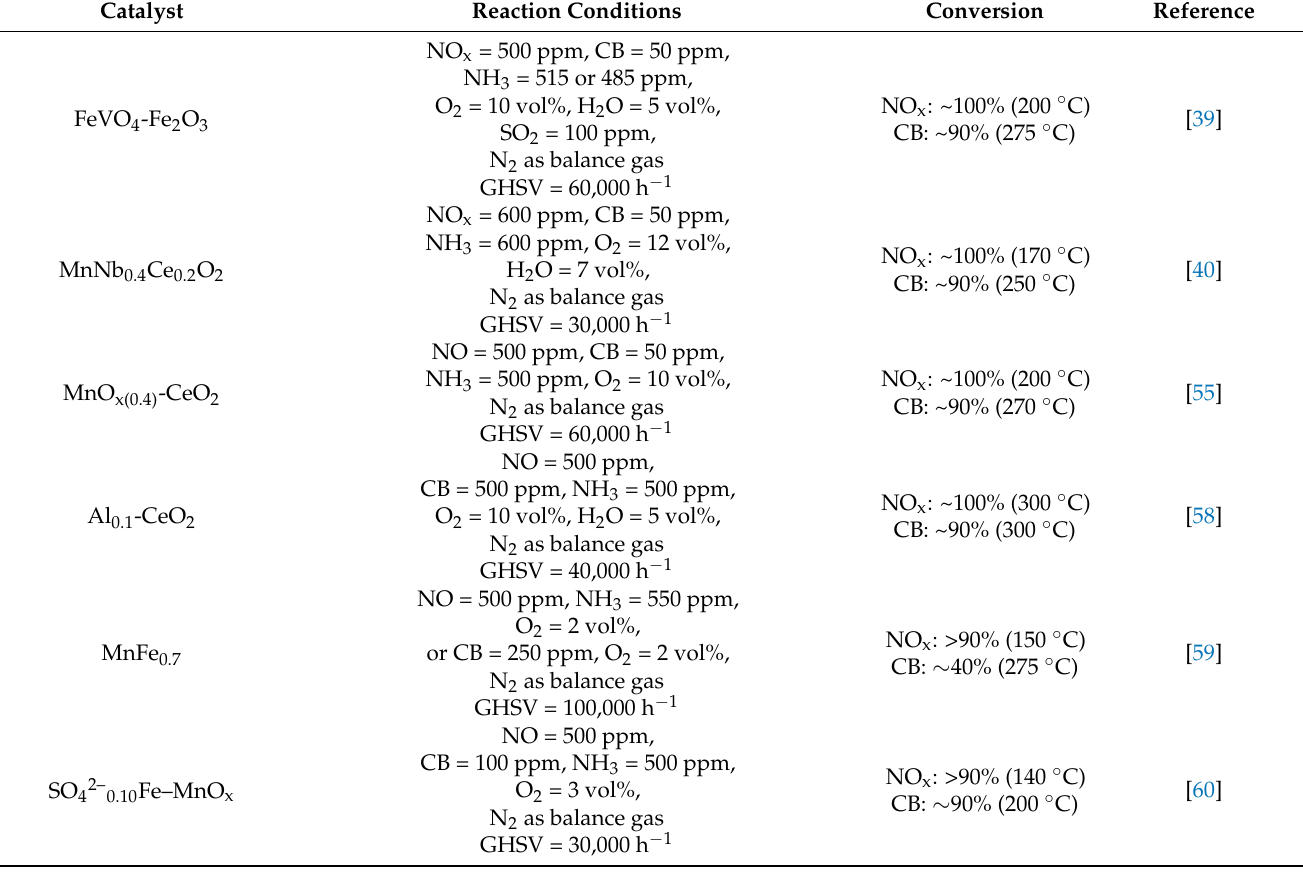
Table 2. Non-loaded transition metal oxide catalysts and their synergistic removal efficiencies for NO and